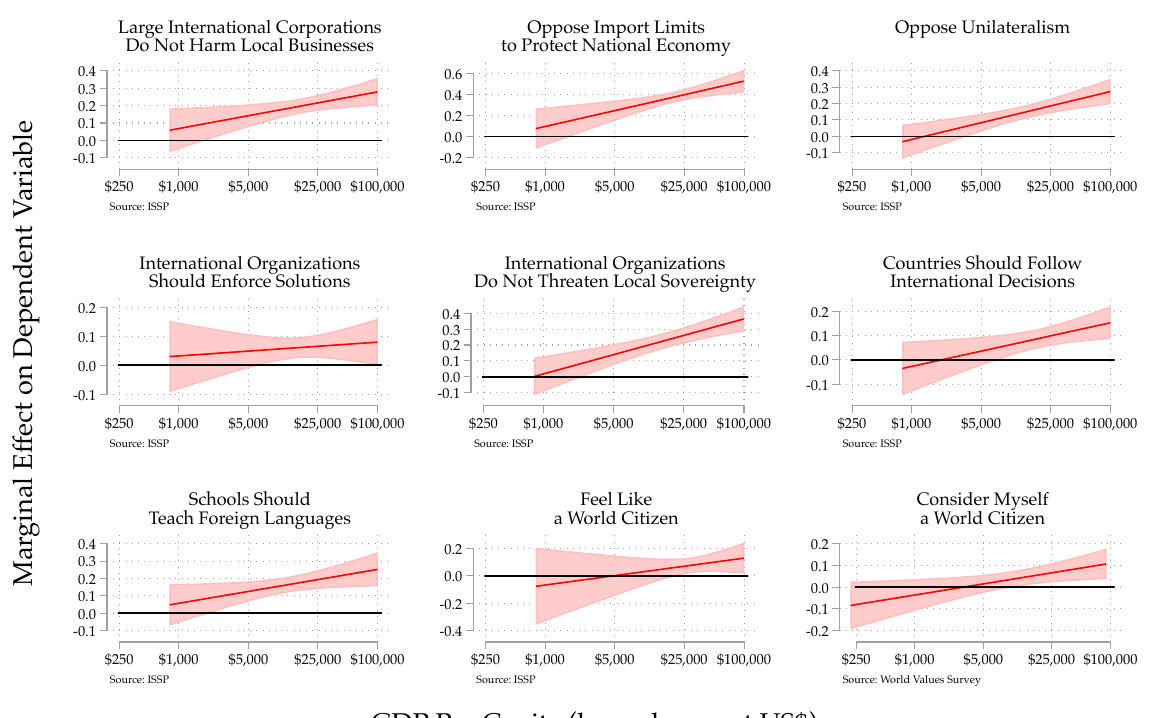
Figure 3: Marginal effect of urban elite status on cooperative-internationalist attitudes at levels of per capita GDP (global surveys). Note: This figure illustrates the marginal effect of belonging to the urban professional elite on each measure of cooperative-internationalist attitudes by levels of per capita GDP (logged scale) with shaded 95 percent confidence intervals. Results are drawn from hierarchical linear regression models in Table 1. The figure shows that gaps between elites and non-elites are more common and larger in higher-income